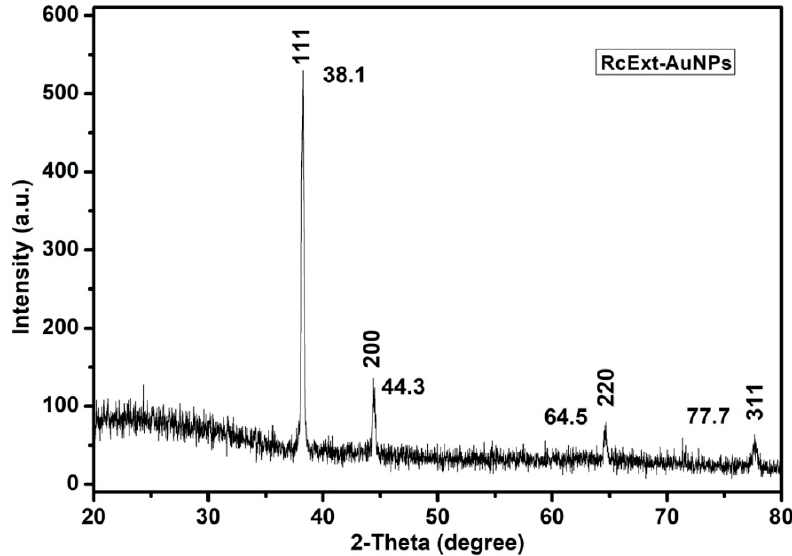
Figure 5. An X-ray diffraction (XRD) pattern of gold nanoparticles (AuNPs) obtained by using Ricinus communis ethanol leaf extract.